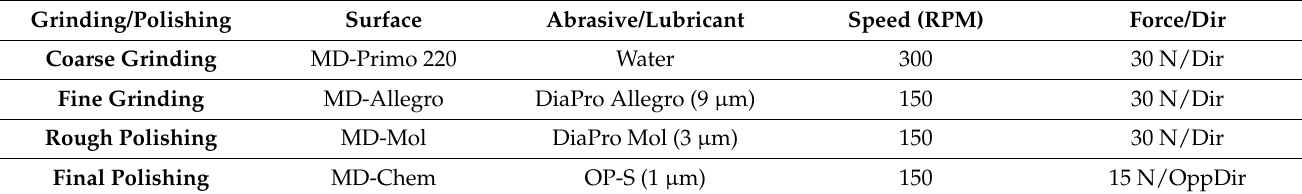
Table 2. Grinding and polishing parameters .